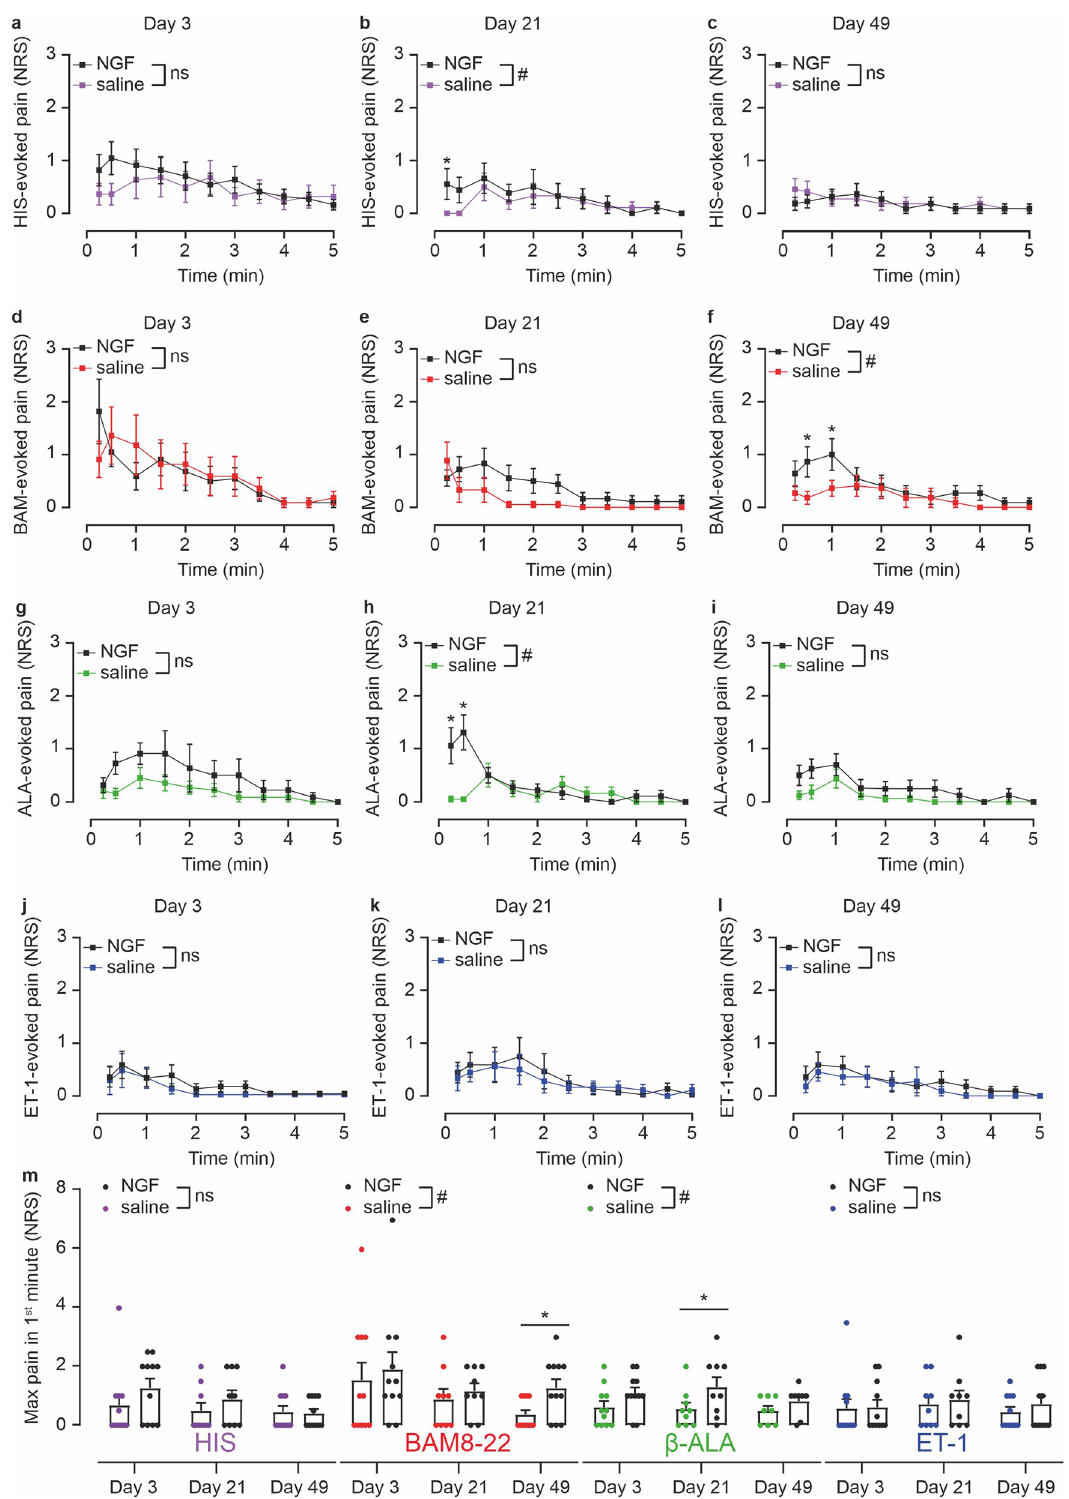
Figure 4. rhNGF enhances pain after injections of non-histaminergic pruritogens. ( a–l ) Pain ratings (NRS, 0–10) upon HIS ( a–c ), BAM8–22 ( d–f ), β-ALA ( g–i ), and ET-1 ( j–l ) recorded for 5 min at 3 days (n = 11), 21 days (n = 9) and 49 days (n = 11; n = 8 for β-ALA) post injection of rhNGF (black symbols) and saline (colored symbols), respectively. rhNGF treatment altered pruritogen-evoked pain for HIS and β-ALA at day 21 (p < 0.05) and for BAM8–22 at day 49 (p < 0.03; both marked with hash signs). Asterisks indicate significant differences at particular time-points (all p < 0.05) and data are depicted as mean ± standard error (SEM). ( m ) Maximum pain during the first minute after pruritogen delivery. In comparison to saline, rhNGF significantly enhanced BAM8–22- and β-ALA- induced pain (p < 0.02 and p < 0.01, marked by hash signs). In particular, pain was stronger at day 49 for BAM8–22 (p < 0.02) and at day 21 for β-ALA (p < 0.05; both marked by asterisks). Data are depicted as mean ± standard error (SEM) with overlay of individual data